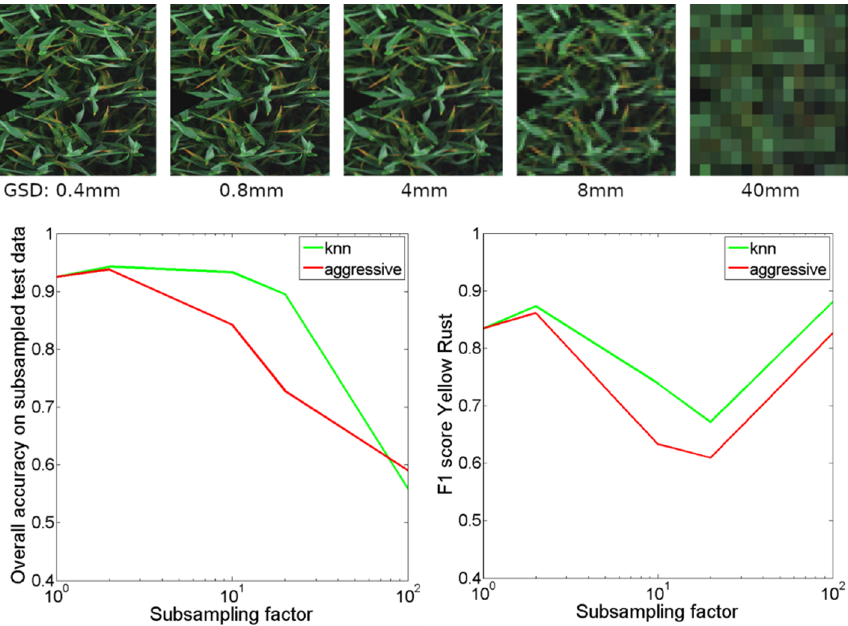
Figure 9. Visualization of spatial subsampling effects for the four investigated subsampling levels (images) and the effect of scale on accuracy and F1 score for the two different approaches knn (nearest neighbor) and an aggressive for subsampling the annotation.